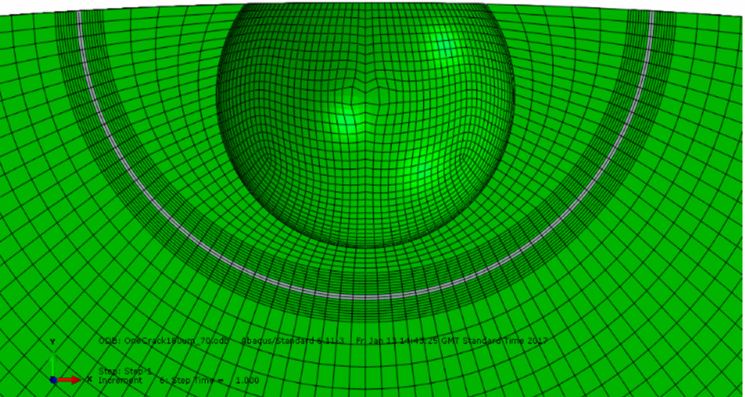
Figure 7. Illustrative FEA mesh around a pit to highlight a continuous crack front extending beyond the pit depth and in this case the crack was just outside the field of plasticity associated with the pit, enabling assignment of K value